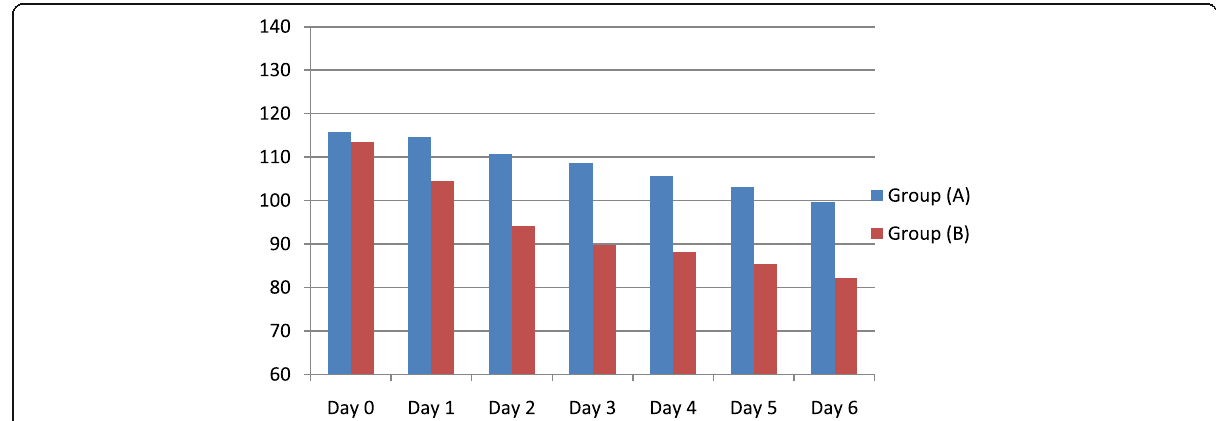
Fig. 6 Bar chart showing the comparison between group A (control) and group B (esmolol) according to the SOFA